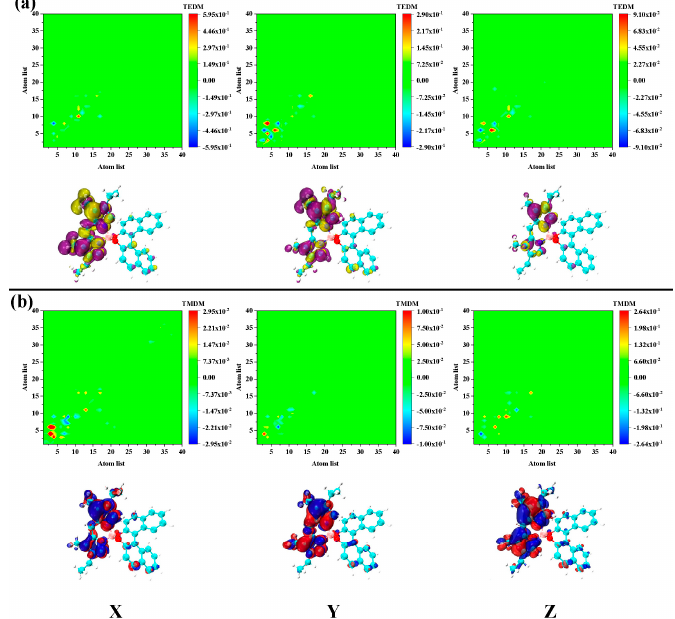
Figure 7. The transition ( a ) electric / magnetic ( b ) dipole moment matrix (upper) and density (under) isosurface of S 4 in PM567. The yellow and purple isosurfaces stand for the positive and negative transition electric dipole moments, respectively, and the red and blue isosurfaces stand for the positive and negative transition magnetic dipole moments, respectively.